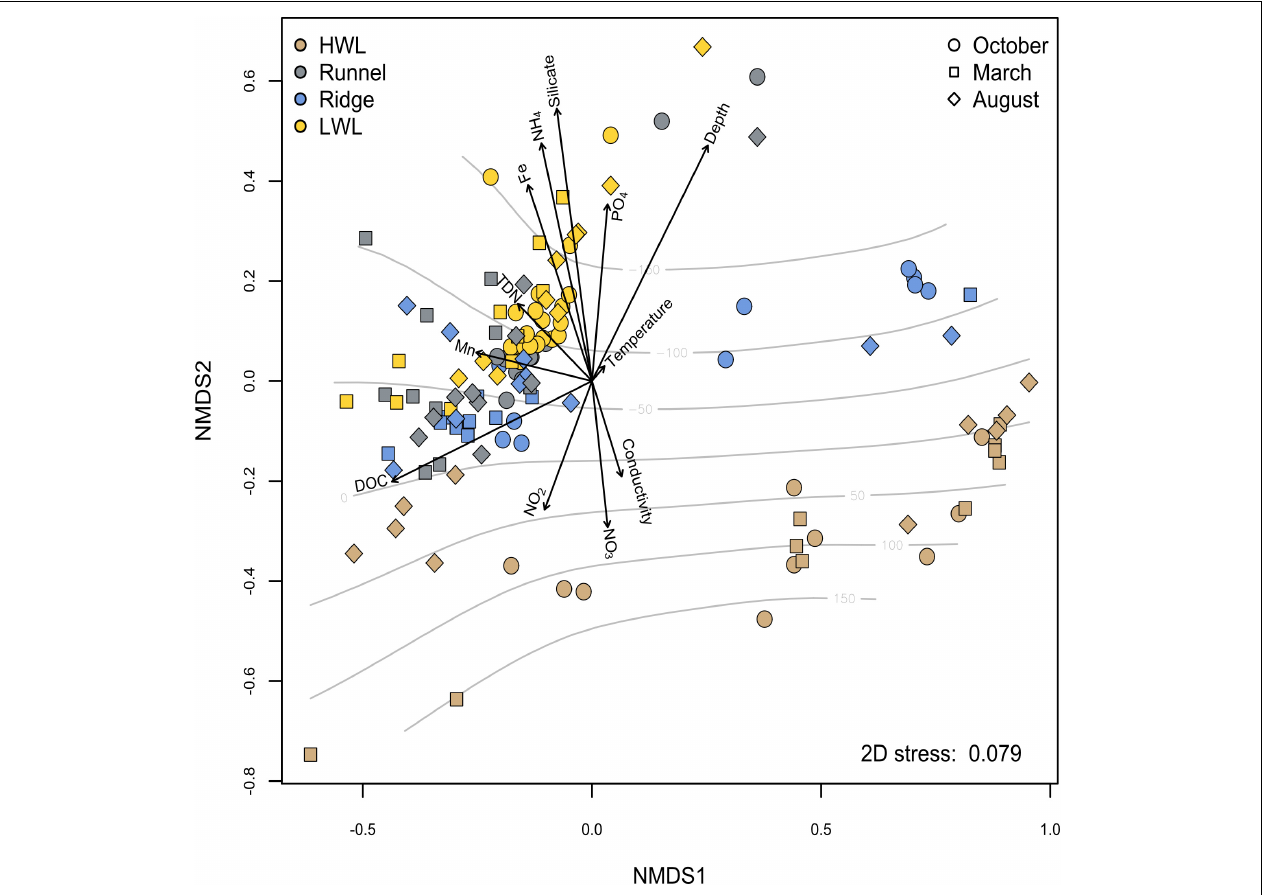
FIGURE 6 | The influence of porewater chemistry on microbial diversity was analyzed using NMDS analysis. Sampling sites are indicated by color coding, while the different symbols indicate the season. Grid lines indicate elevation above or below sea level. Data points closer to the center of the vector matrix are more similar to each other and influenced less by the parameters